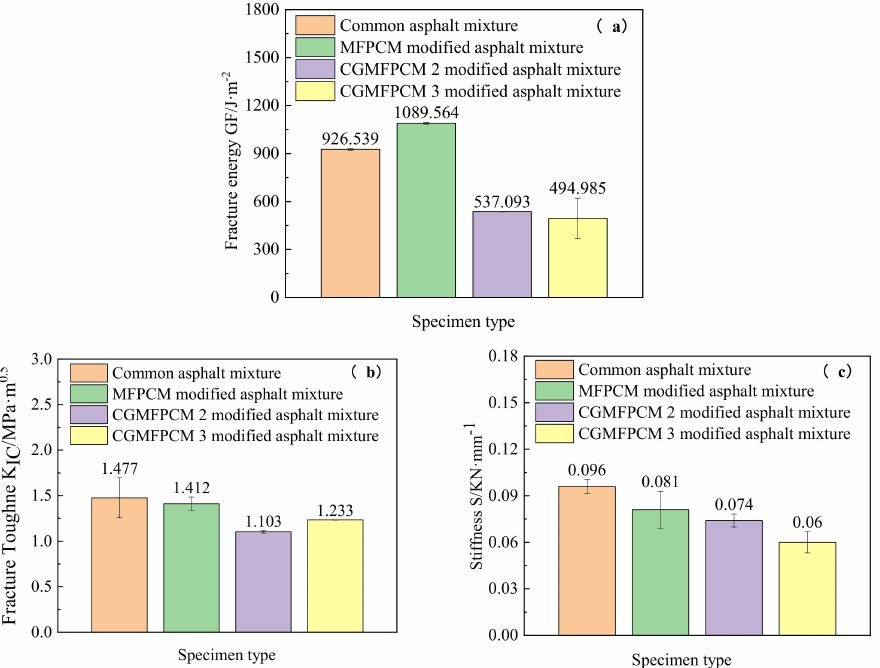
Figure 4. SCB test ( − 10 ◦ C) results for common and modified asphalt mixtures: ( a ) the fracture energy G f , ( b ) the fracture toughness K IC and ( c ) the stiffness